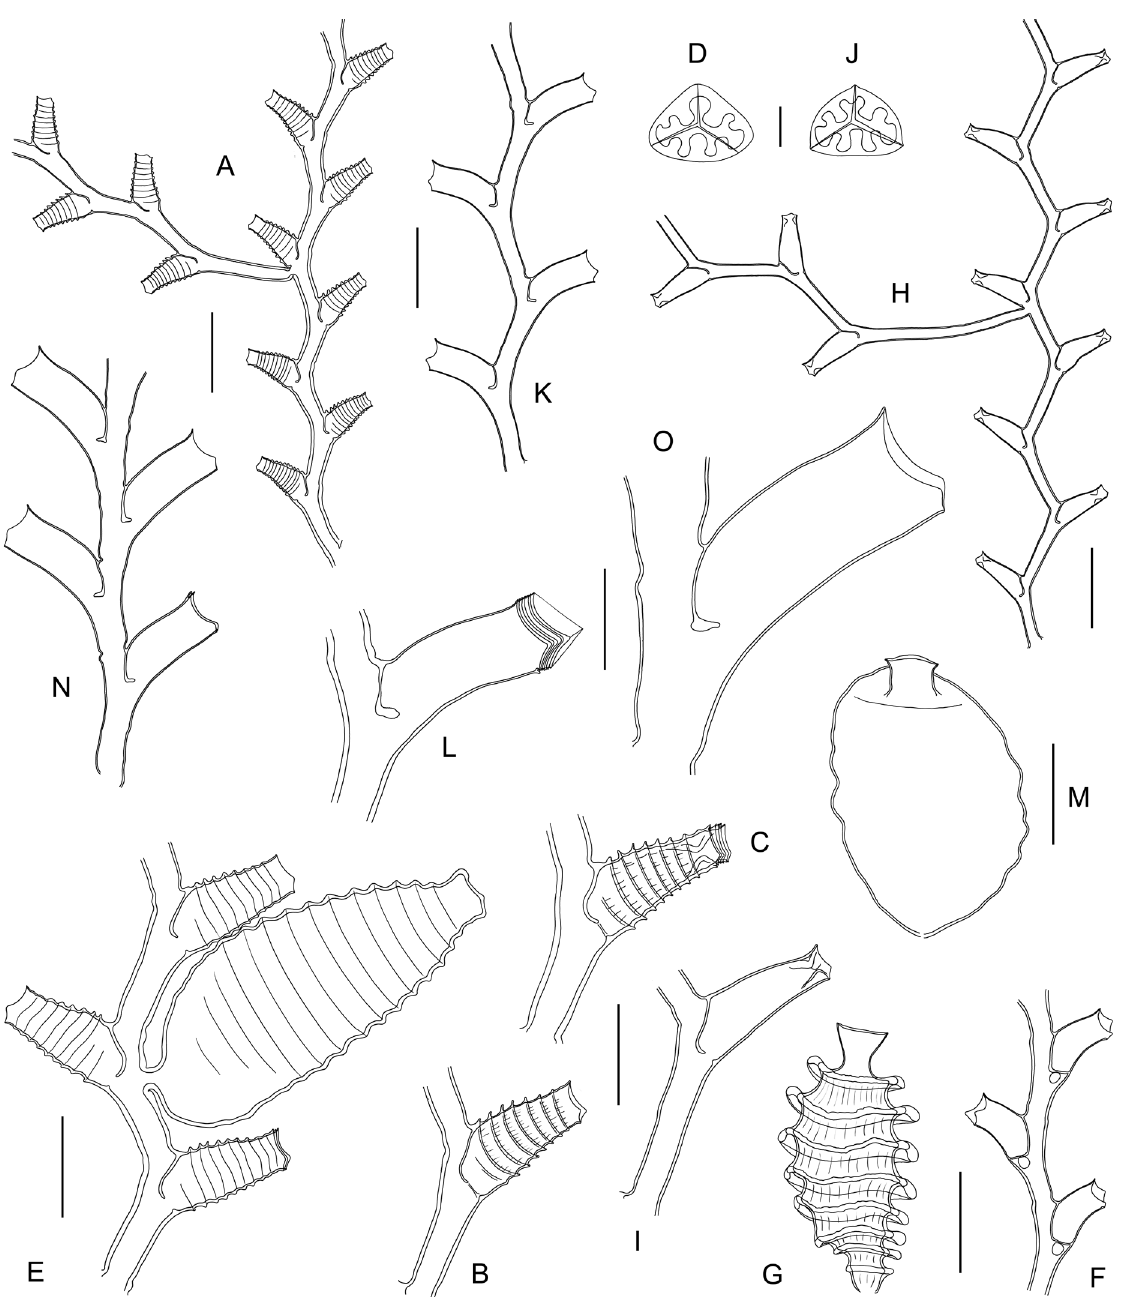
Fig. 17. A–E . ? Symplectoscyphus acutustriatus Galea, sp. nov., portion of stem with side branch (A, from sample MNHN-IK-2015-460); hydrothecae without (B) and with (C) internal, submarginal cusps, aperture in apical view (D), portion of colony with gonotheca (E), all from sample MNHN- IK-2015-461. — F–G . Symplectoscyphus commensalis Vervoort, 1993, portion of colony with internodes and hydrothecae (F), gonotheca (G), both from sample MNHN-IK-2015-399. — H–J . ? Symplectoscyphus elongatulus Galea, sp. nov., portion of stem with proximal part of cladium (H), hydrotheca (I), apical view of aperture showing submarginal, intrathecal cusps (J), all from sample MNHN-IK-2015-463. — K–M . Symplectoscyphus paulensis Stechow, 1923, colony fragment (K), hydrotheca (L), gonotheca (M), all from sample MNHN-IK-2015-393. — N–O . Symplectoscyphus cf. tropicus (Hartlaub, 1901), portion of colony (N), hydrotheca (O), both from sample MNHN-IK-2015-394. Scale bars: A, H, K, N = 1 mm; B–C, E–G, I, L–M, O = 500 µm; D, J =